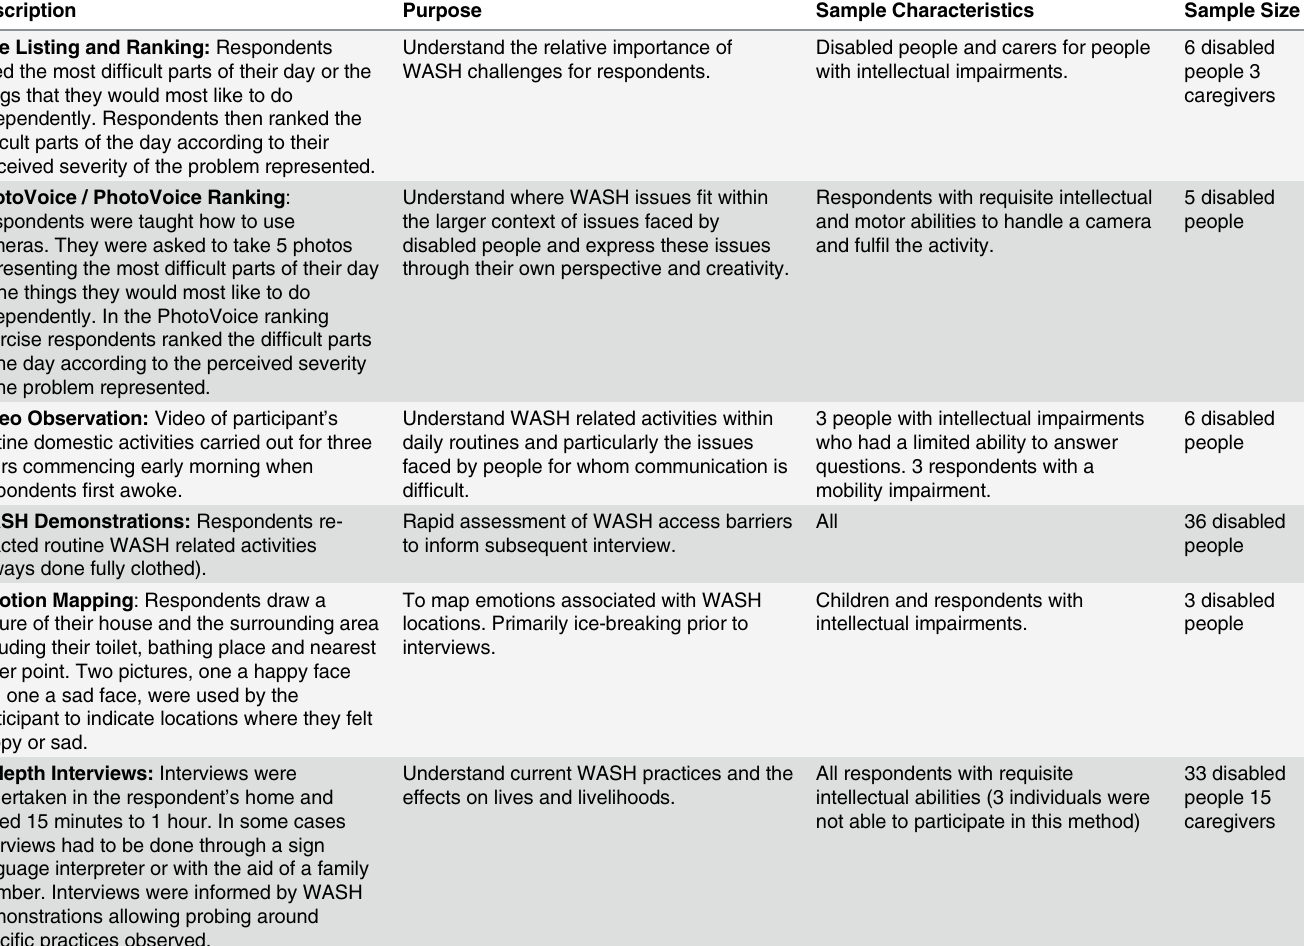
Table 2. Summary of